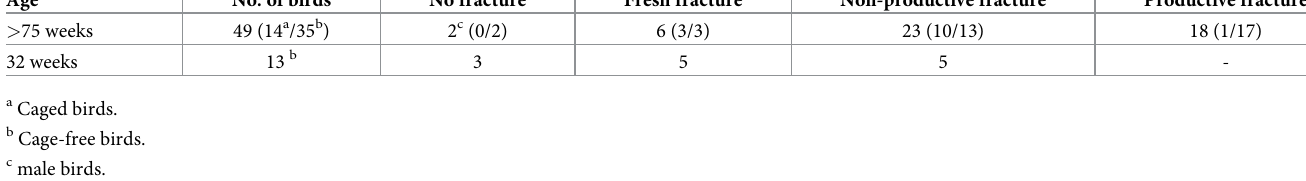
Table 1. Overview of macroscopic fracture characteristics in birds selected for CT-scan and histomorphological fracture characterization. Age No. of birds No fracture Fresh fracture Non-productive